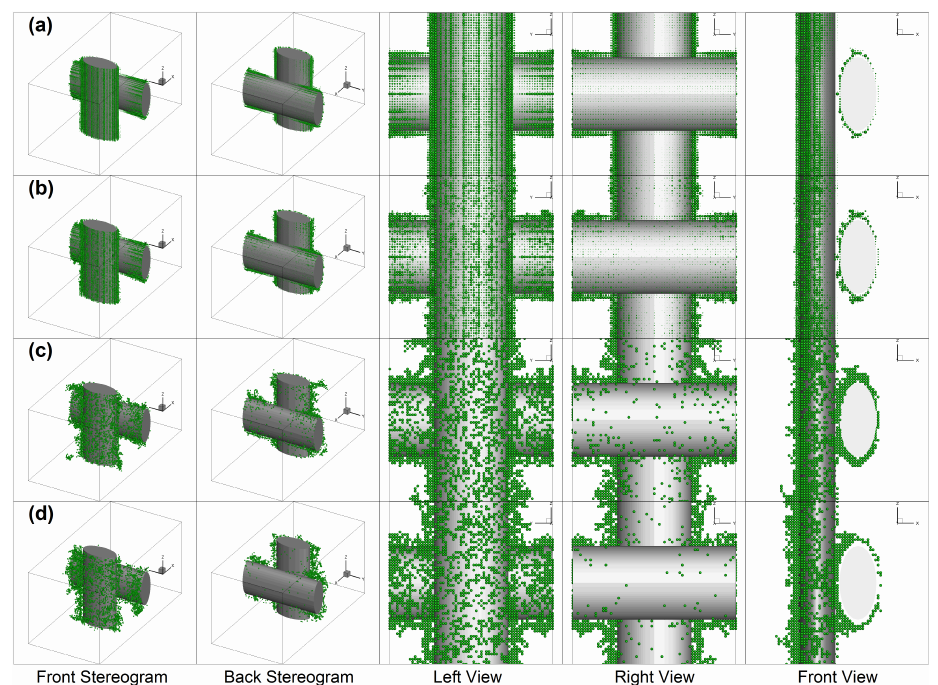
Figure 6 Figure 6. Dendrite structures with different particle parameters: ( a ) Case 1, d d p = 0.4 µ m; ( c ) Case 3, d p = 1.0 µ m; ( d ) Case 4, d p = 2.0 µ